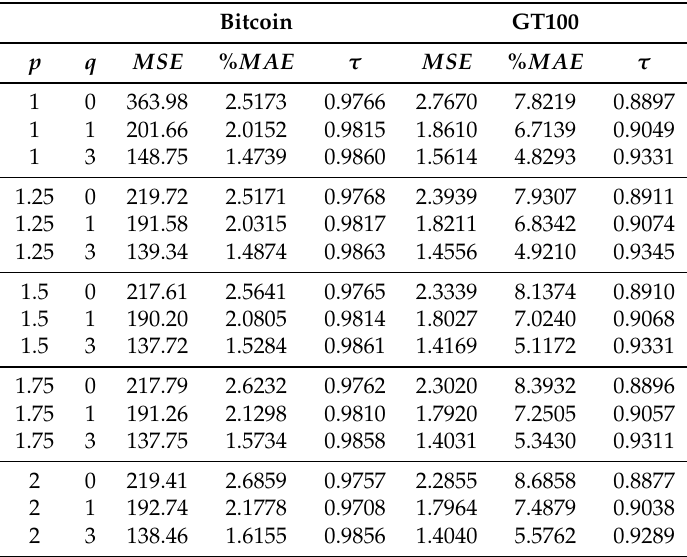
Table 3. Approximation indices for L p -norm F-transform of Bitcoin and GT100 For five values p ∈ { 1,1.25,1.5,1.75,2 } and three orders q ∈ { 0,1,3 } the table shows indices MSE , % MAE , and Kendall τ correlation for the pairs ( f , f ( r ) ) with f ∈ { Bitcoin , GT 100 } . Bitcoin